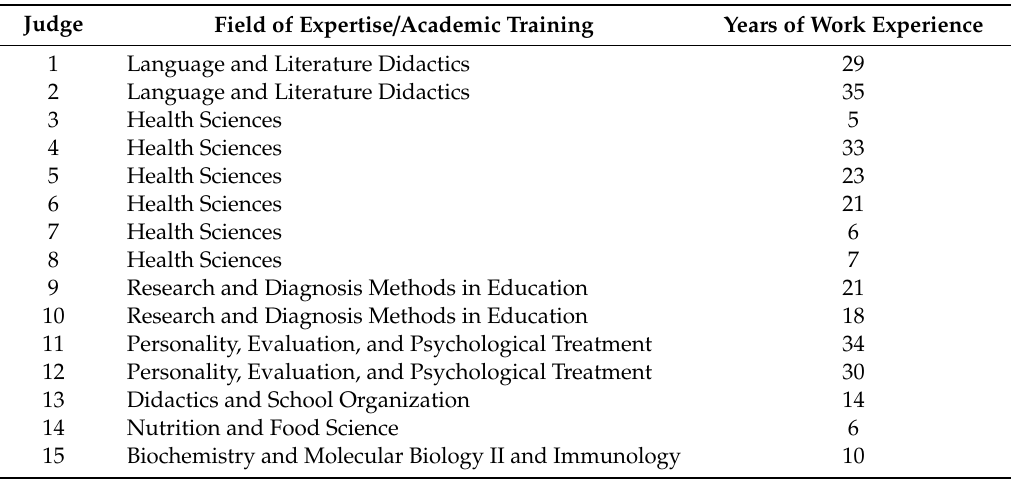
Table 1. Judges, areas of knowledge, and work